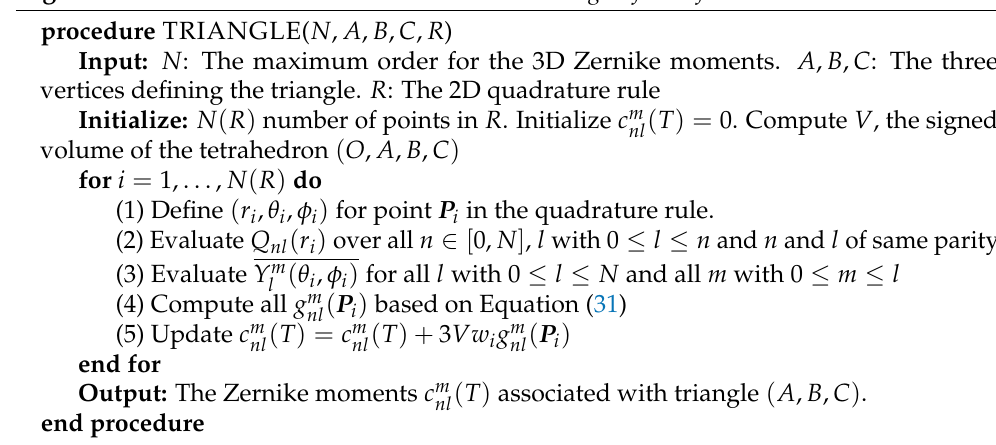
Algorithm 1 Zernike moments associated with one triangle of a surface mesh